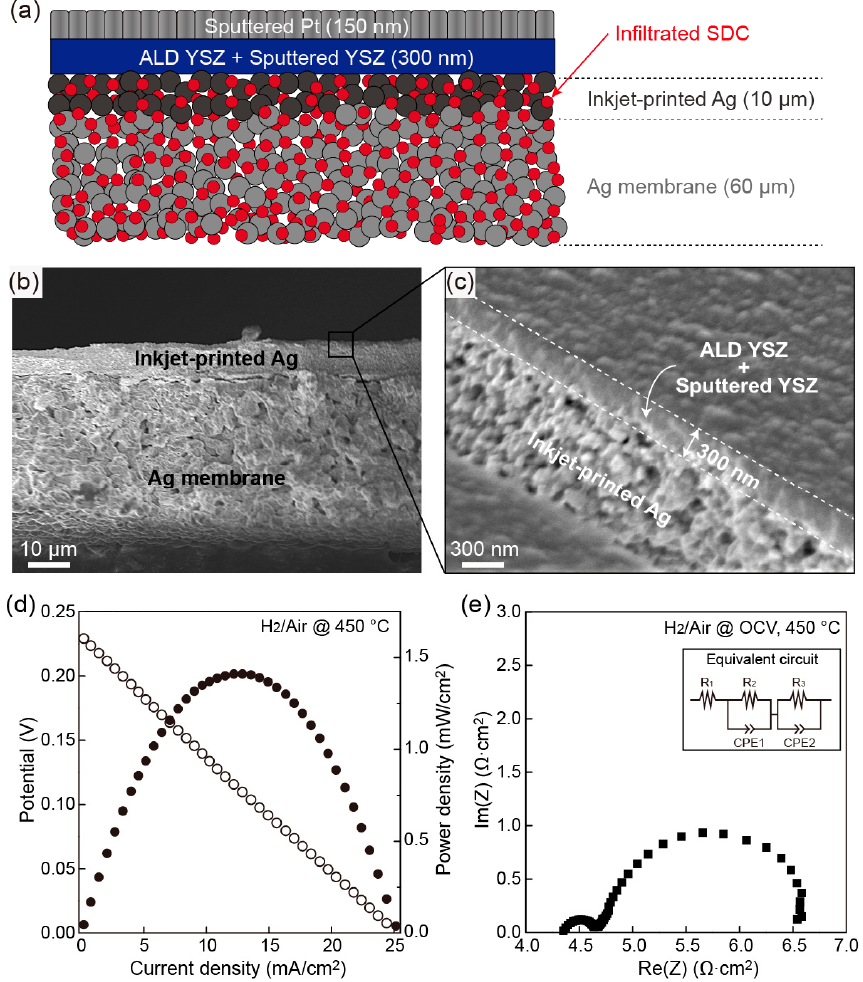
Figure 4. ( a ) Schematic of SDC-infiltrated Ag cathode-supported SOFC. ( b ) Cross-sectional FESEM image of SDC-infiltrated Ag cathode. ( c ) Cross-sectional FESEM image near YSZ electrolyte layer. ( d ) Polarization curve and ( e ) Nyquist plot (acquired at open circuit voltage) of SDC-infiltrated Ag cathode-supported cell measured at 450 °C. Inset: equivalent circuit model for EIS fitting.